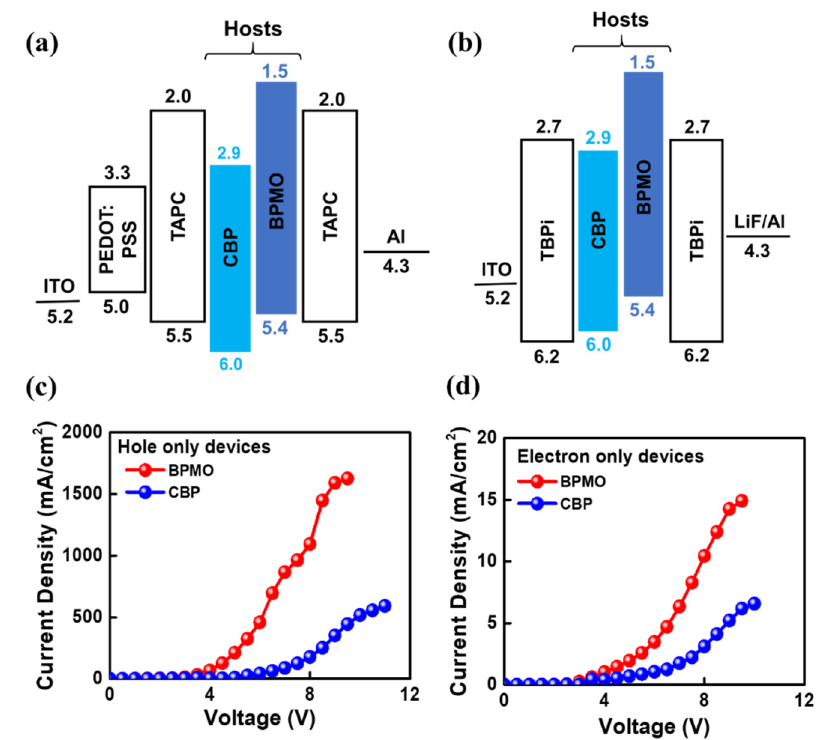
Figure 3. Schematic energy level diagrams of ( a ) hole-only, ( b ) electron-only devices, current-density-voltage curves of BPMO- and CBP-based ( c ) hole-only devices, and ( d ) electron-only devices. The cures reveal that BPMO host composing device has better charge-carrier mobility than CBP.